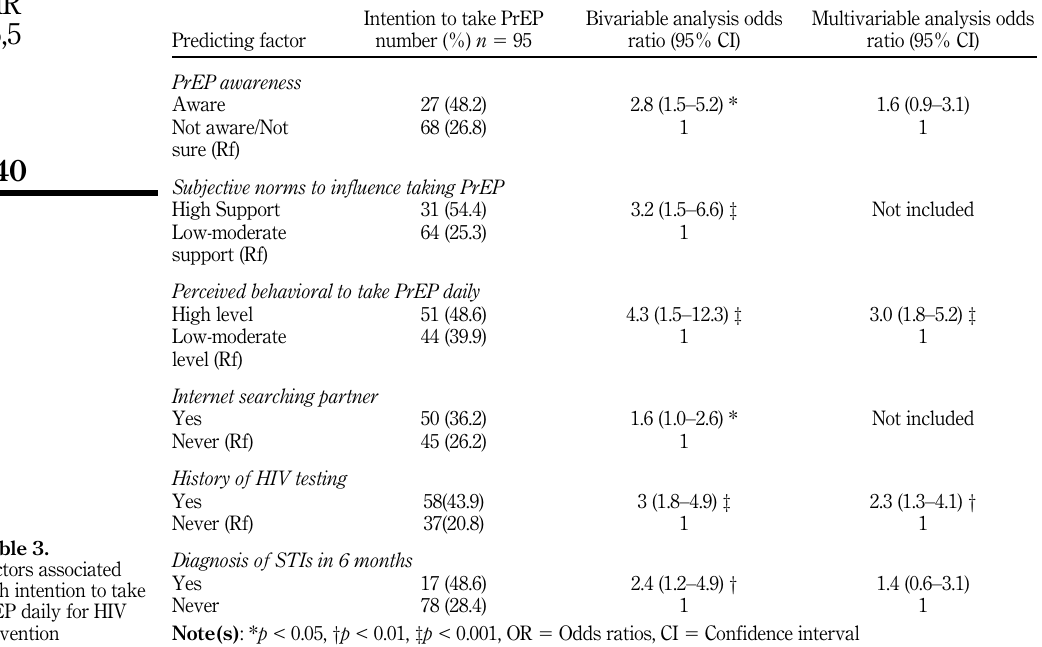
Table 3. Factors associated with intention to take PrEP daily for HIV